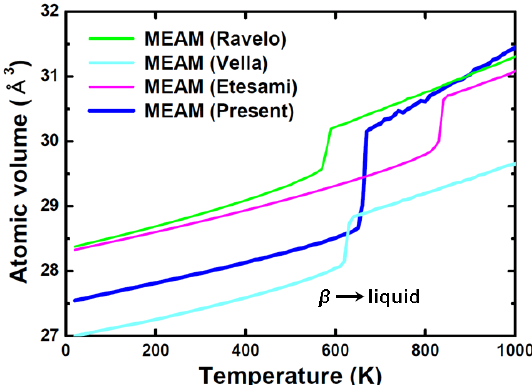
Figure 2. Atomic volume dependence of pure Sn, calculated using the present 2NN MEAM potential, in comparison with the calculation results using previous MEAM potentials by Ravelo and Baskes [5], Vella et al. [12], and Etesami et al. [13]. The heating simulations were started with the β phase at 5 K. The discrete jumps represent the occurrence of the melting.